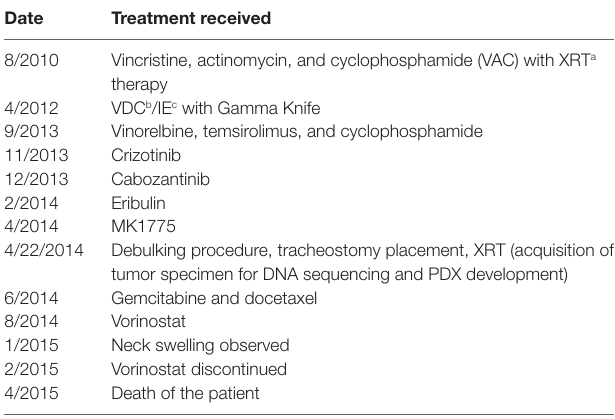
table 1 | Summary of relevant clinical